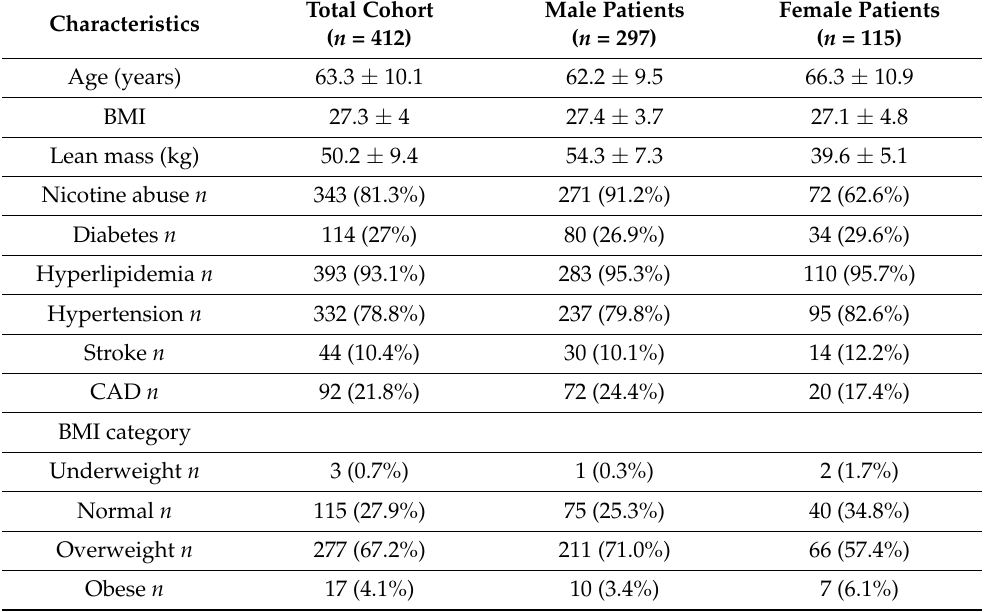
Table 2. Patient